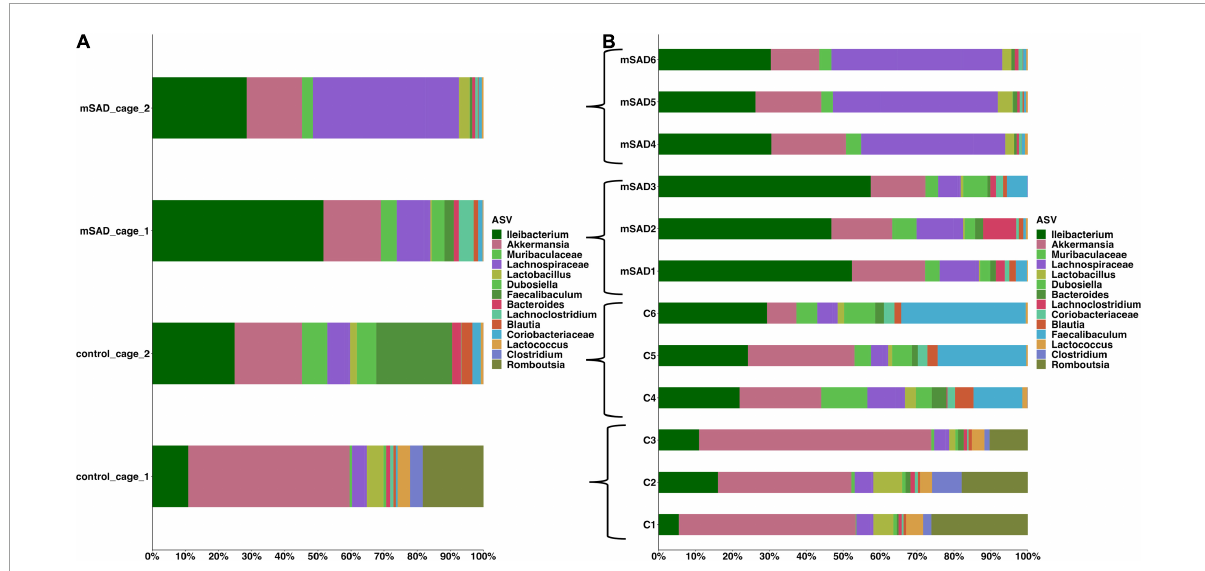
FIGURE9 The mean of each sample group, according to cage was plotted for clarity, across sample groups (A) . Sample assignments are as follows: mSAD = mice fed the mSAD diet, control/con = mice feed the control diet, and cage represents their respective cage. Relative abundance stacked column bar graph showing top 15 taxa at the most resolved level across all samples ( n = 3 for each sample) in the gut ecosystem of mus musculus (B) . Taxonomic identities were based on their assignment through the (SILVA v138) database as determined by the Quantitative Insights into Microbial Ecology (QIIME_2, v2021.11) and graphed using R (ggplot